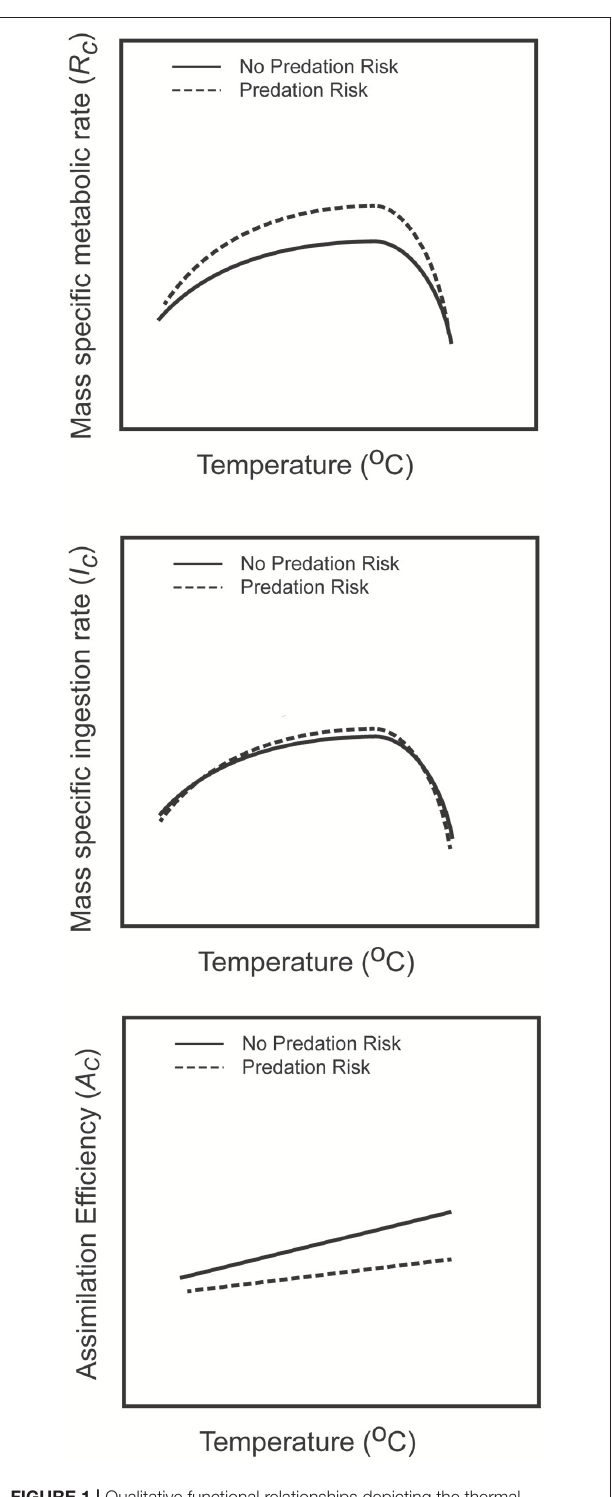
FIGURE 1 | Qualitative functional relationships depicting the thermal performance of prey metabolism, prey resource ingestion rate and assimilation efficiency in the presence and absence of perceived predation risk. These relations summarize known empirical relationships derived from experimental analyses reported in the literature. These relationships are characterized mathematically to predict the temperature sensitivity of prey selection for C and N in risk and risk free